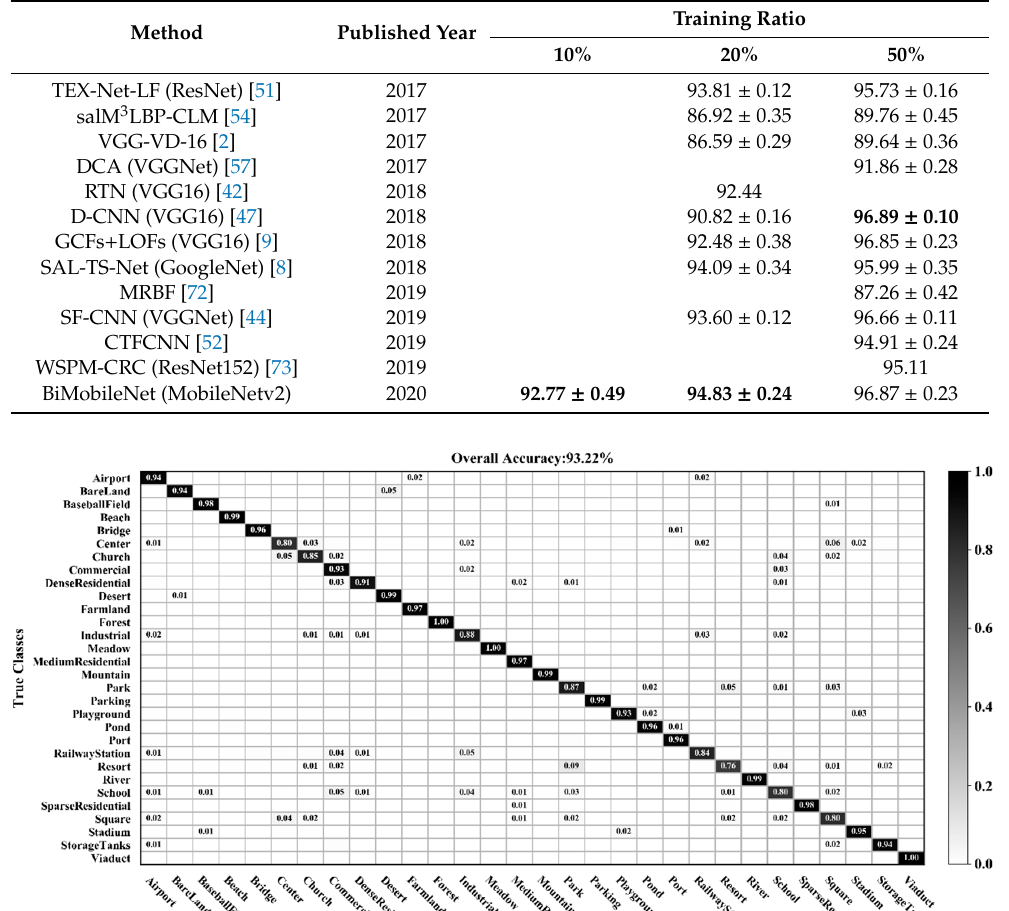
Figure 15. Confusion matrix using a training ratio of 50% on the AID dataset. 3.3. Classification of the NWPU-RESISC45 Dataset For the NWPU-RESISC45 dataset, training data ratios were set to 10% and 20%. The classification accuracies of state-of-the-art methods and BiMobileNet are shown in Table 6. The NWPU-RESISC45 dataset has more categories and images than the other two datasets. The overall accuracy of BiMobileNet is 92.06% and 94.08% when the training ratios are 10% and 20%, respectively; this is higher than all but one other methods. When the training ratio is 10%, BiMobileNet accuracy is 2.1%, 1.5% and 0.3% higher than SF-CNN [44], ADFF [46] and DML [49], respectively, and is similar to DDRL-AM [41]. SF-CNN, ADFF, and DML adopt deep CNN VGG16; DDRL-AM adopts deep CNN ResNet18. The parameters and calculation of these two networks are significantly larger than MobieNetv2 used in BiMobileNet. In addition, when the training ratio is 20%, BiMobileNet accuracy is ~1.5%, ~2.1%, ~0.6%, and ~1.6% better than SF-CNN, ADFF, DML and DDRL-AM, respectively. Figures 16 and 17 show the confusion matrixes obtained by BiMobileNet using training ratios of 10% and 20%, respectively, on the NWPU-RESISC45 dataset. When the training ratio is 10%, the classification accuracy of 35 categories is greater than 90%, while the ADFF method classifies 30